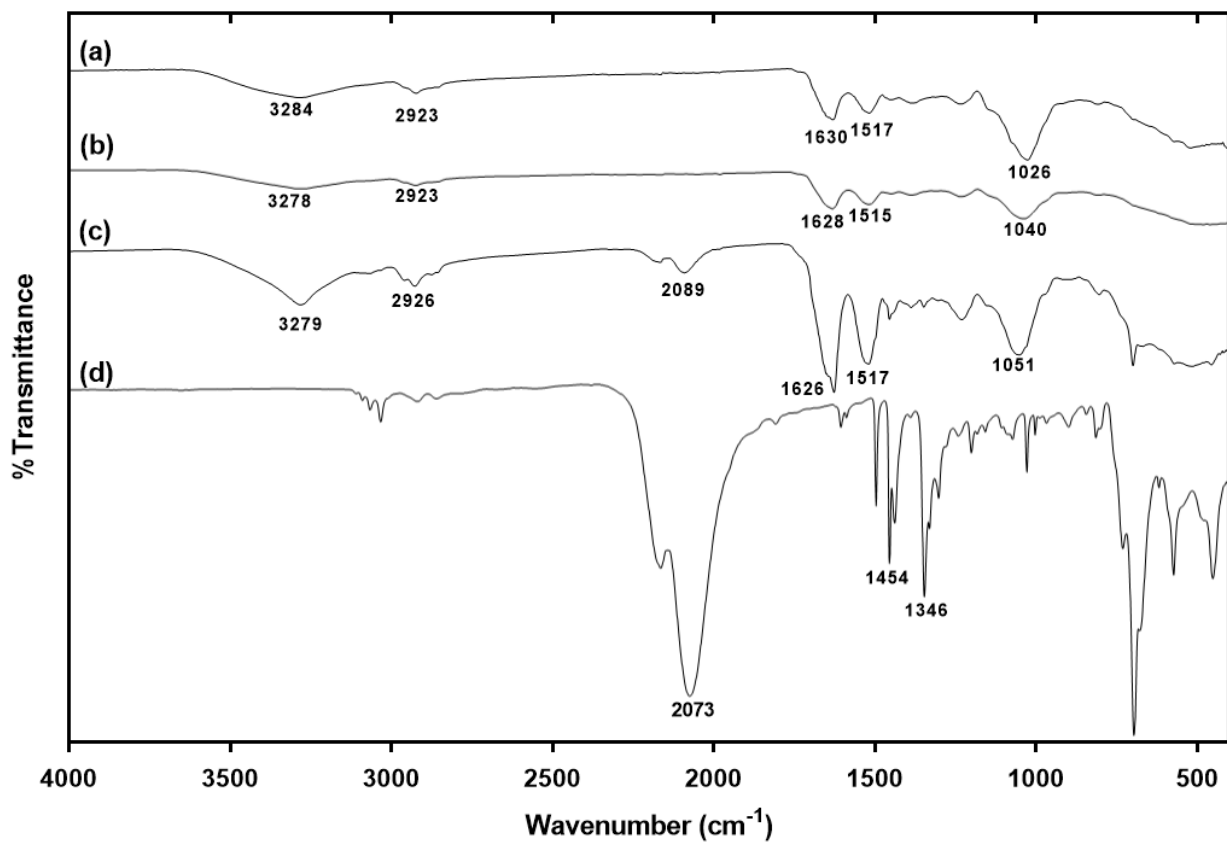
Figure 3. Fourier transform infrared spectroscopy ( FT − IR) spectra of non − plasmolyzed yeast cells ( a ), plasmolyzed yeast cells ( b ), benzyl isothiocyanate − loaded plasmolyzed yeast cells ( c ), and pure benzyl isothiocyanate ( d ).